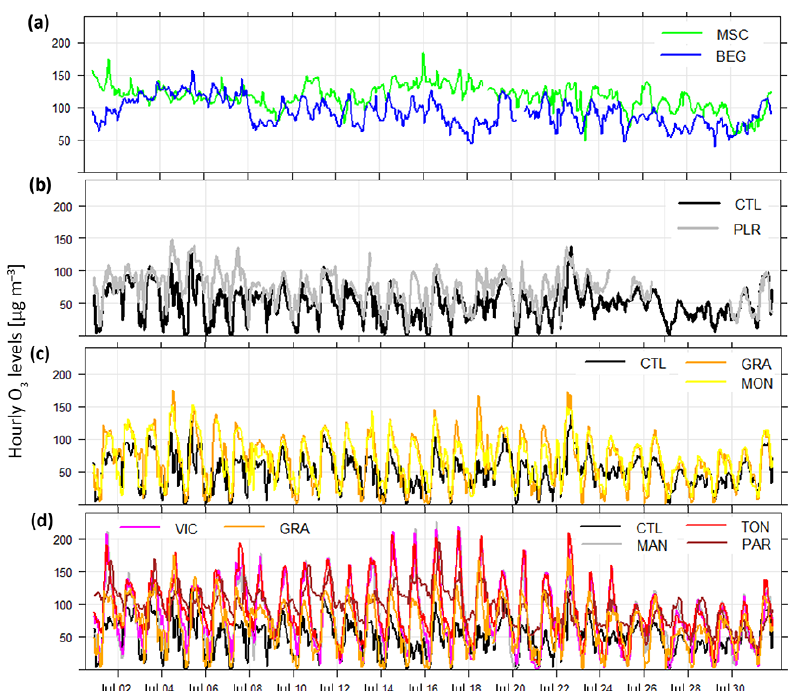
Figure 5. O 3 hourly concentrations recorded at the coastal (BEG, blue) and remote inland western pre-Pyrenean (MSC, clear green, 1570ma.s.l.) sites, two urban background sites of Barcelona (PLR, CTL, grey and black), two urban sites in the northern periphery of Barcelona metropolitan area (GRA, MON, orange and yellow), the inner Vic Plain sites (TON, VIC and MAN, red, pink and violet) and the remote eastern pre-Pyrenean site of PAR (brown), during July 2015.